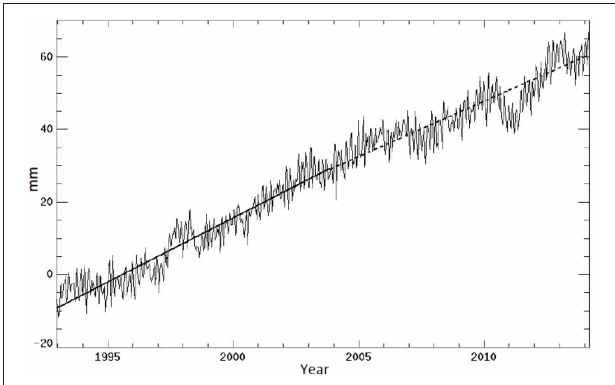
FIGURE 2 | The auto covariance of the time series shown in Figure 1.